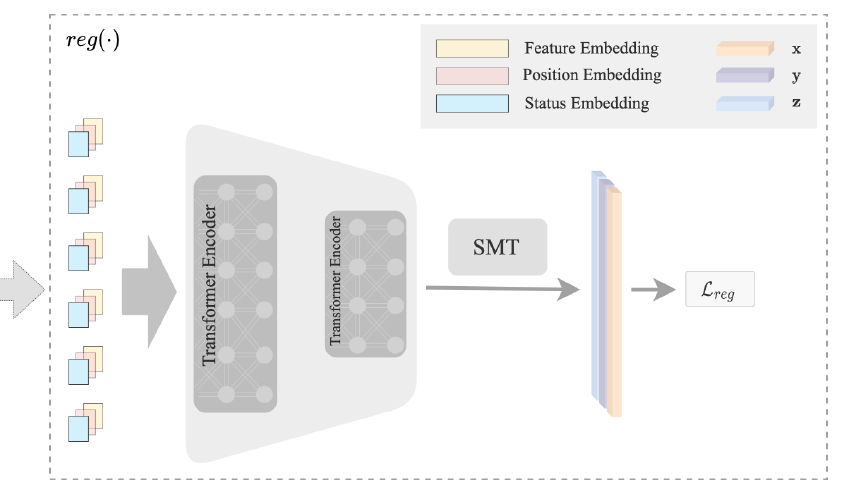
Figure 3. The structure of the reg ( · ) branch. The input is the concatenation of feature embed- ding, position embedding, and status embedding. Sequential transformer blocks are adopted to reduce the dimension of the hidden embedding progressively. The final output is the coordinates of the